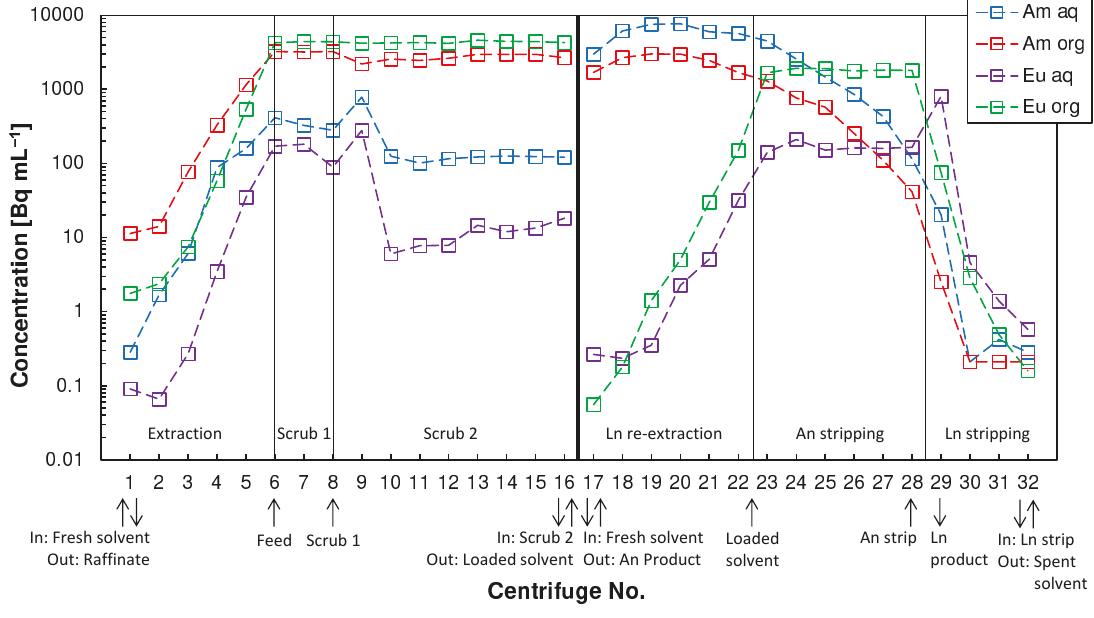
Figure 8. Am and Eu stage profiles of the ALSEP demonstration test (data from ICP-MS measurements, in very well agreement with data from gamma